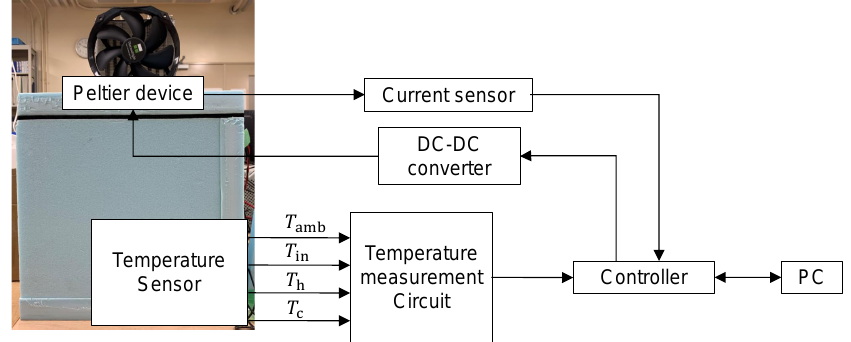
Figure 6. Implementation of the experimental system [5].